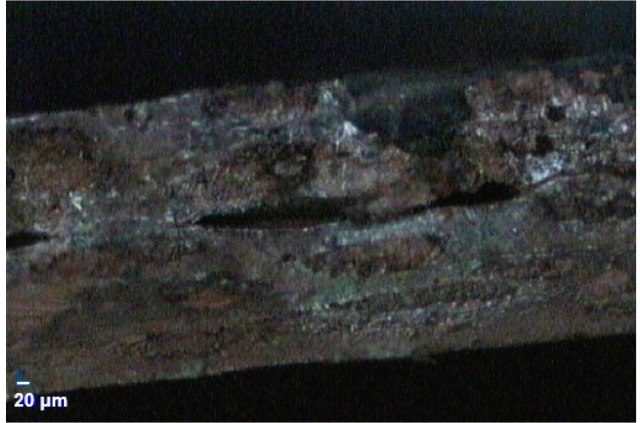
Figure 10. PTFE layers are not properly laminated without a bonding layer.